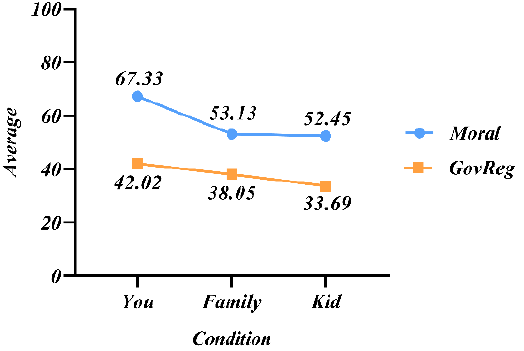
Figure 6. Mean values of participants’ moral evaluation scores on swerving choices with different passenger compositions.